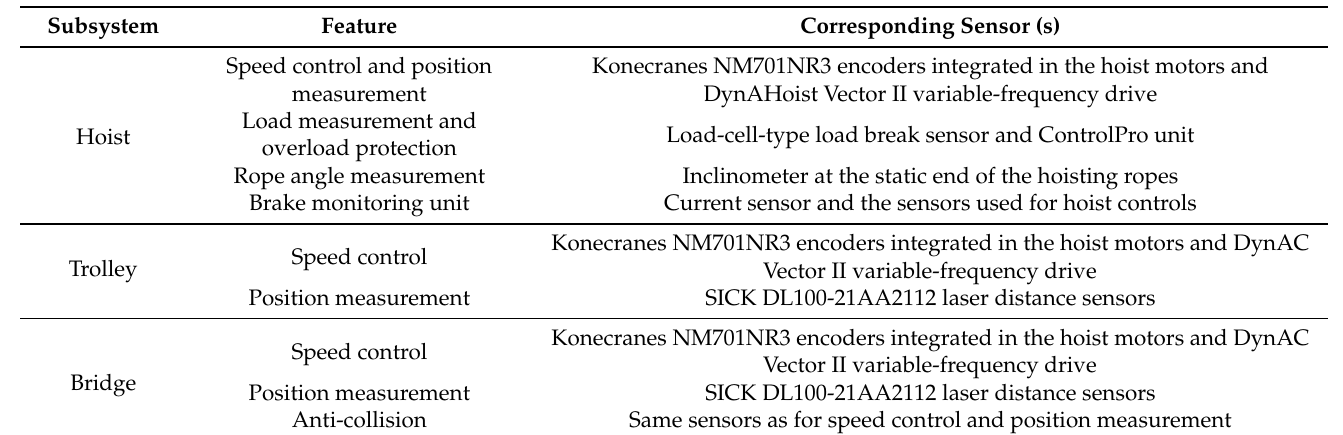
Figure 1. The smart overhead crane at the Aalto Industrial Internet Campus. Table 1. Features and corresponding sensors of the smart overhead crane